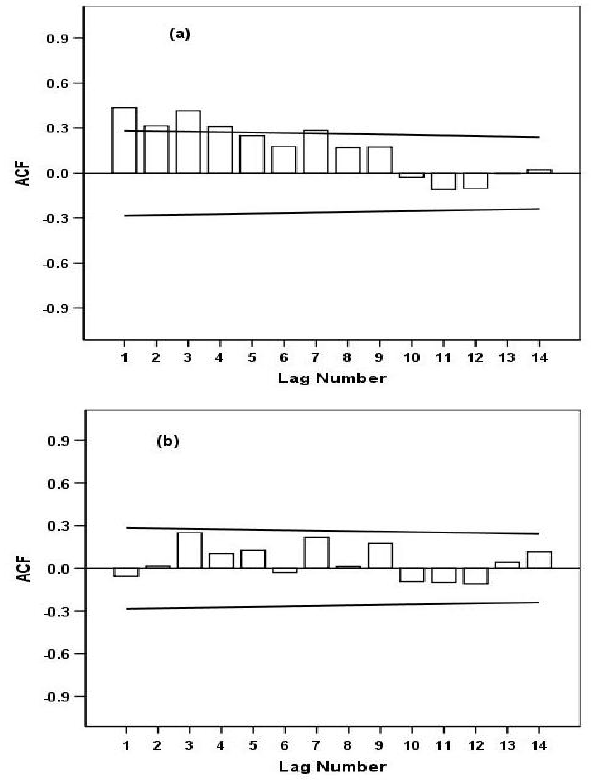
Figure 3. Autocorrelation function for the warmest day (WD) time series of the Fig. 3. Autocorrelation function for the warmest day (WD) time observatory of Amurrio [Alava province] (a) before and (b) after application of the series of the observatory of Amurrio (Alava province) (a) before prewhitening procedure (solid line refers to the upper and lower limit of the 95 % and (b) after application of the prewhitening procedure (solid line 1 refers to the upper and lower limit of the 95% significance level significance level given by ± 1.96 ( n ) where n = 47 for the period 1960-2006. given by ± 1.96 ( 1 √ ) where n = 47 for the period n